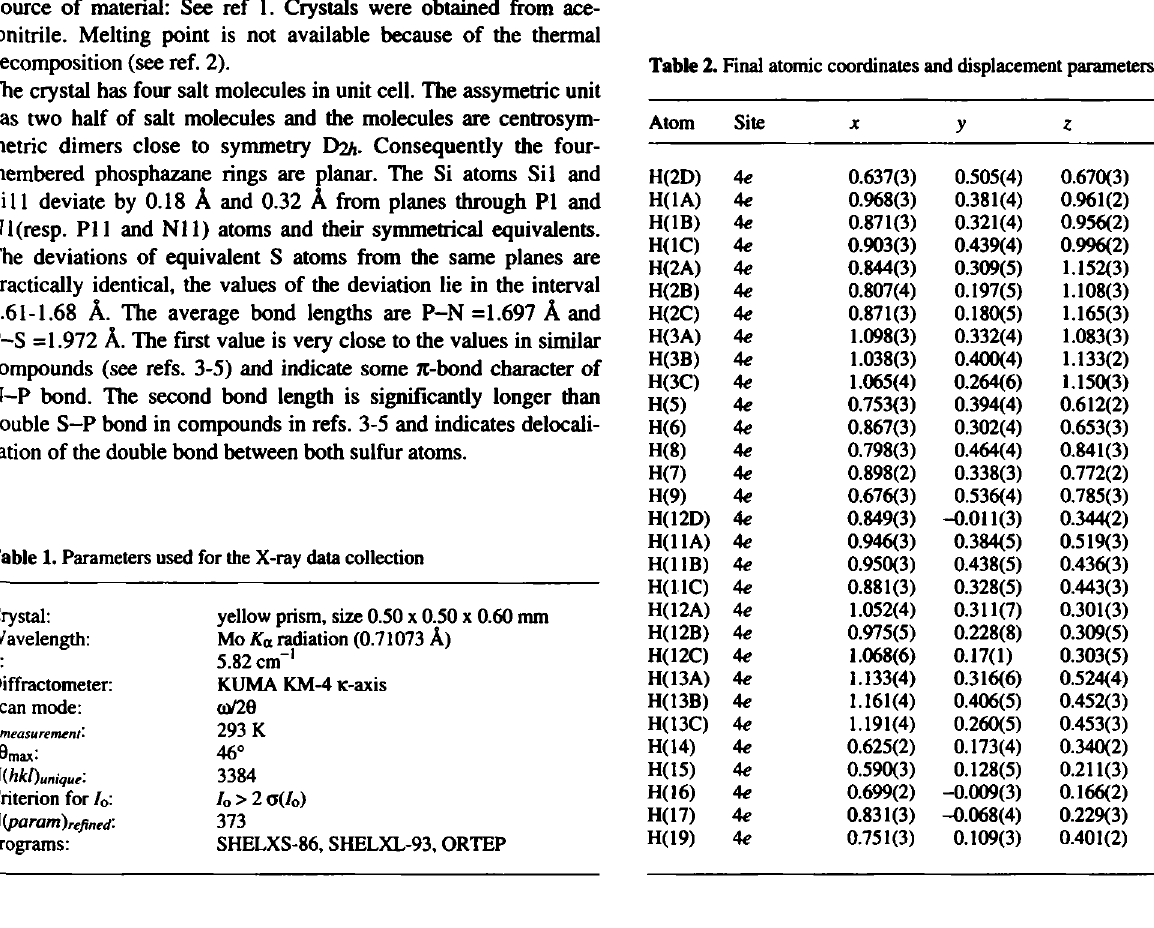
Table 1. Parameters used for the X-ray data collection Crystal: